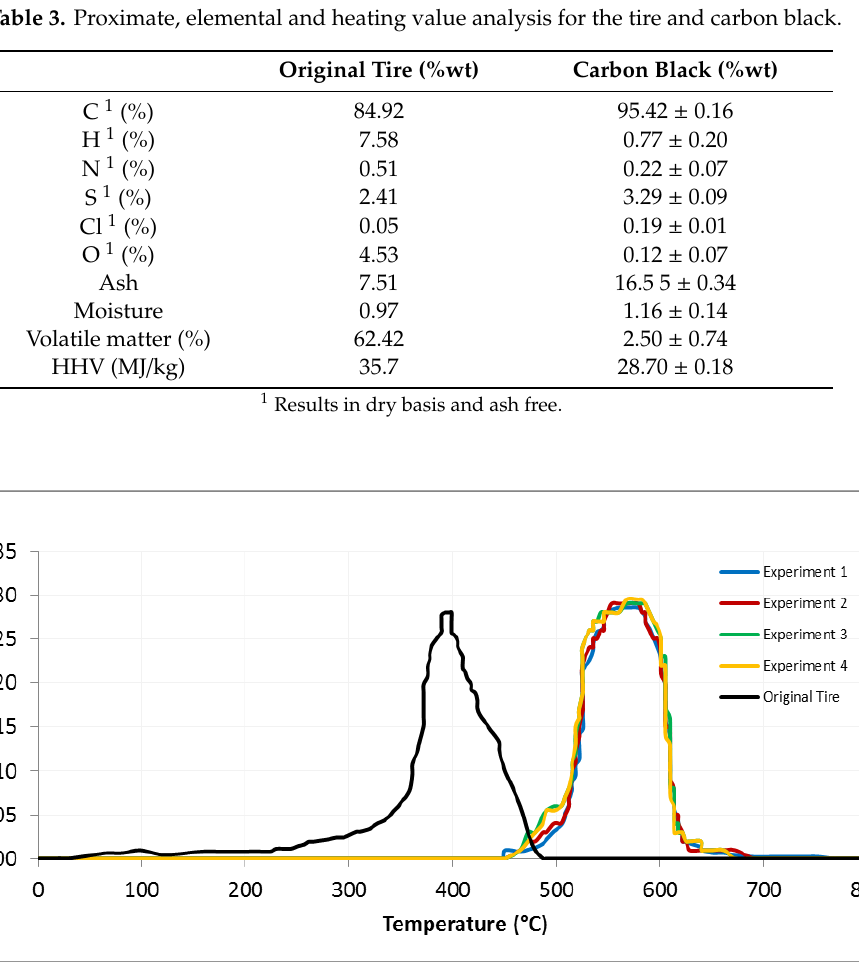
Figure 4. Derivative Thermogravimetry (DTG) plots of the original tire and the pyrolysis carbon black (PCB) fractions obtained from the four experiments.